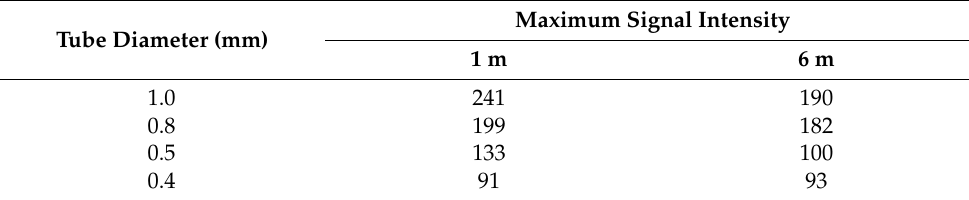
Table 3. Maximum signal intensities of tubes with various diameters and lengths in 3D High TOF